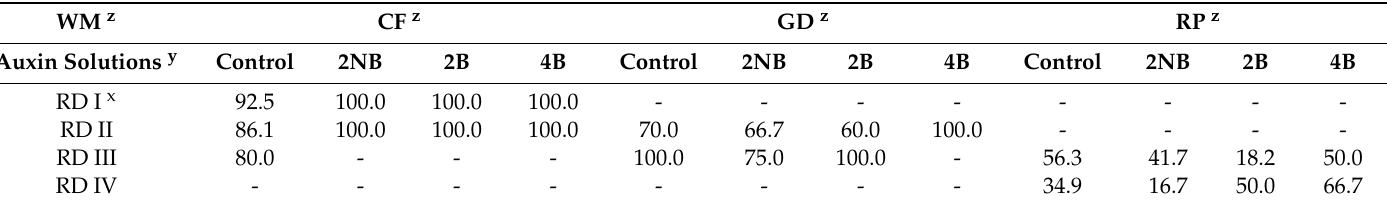
Table 2. The rooting percentage of wounding method (WM), root diameter (RD), and auxin solution treatment combinations on the F. elastica heritage tree.